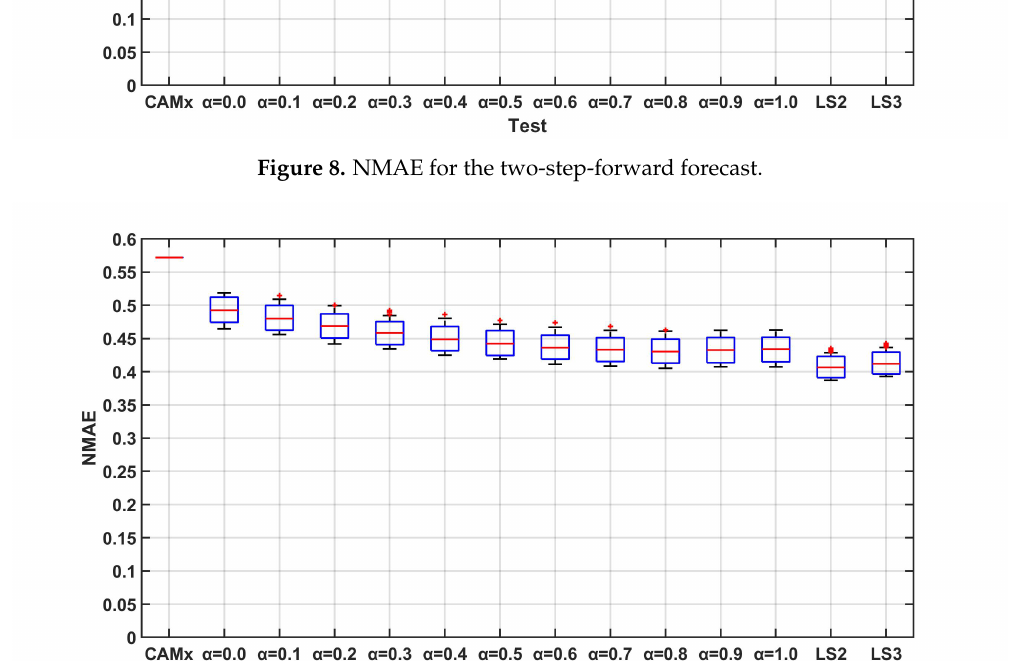
Figure 9. NMAE for the three-step-forward